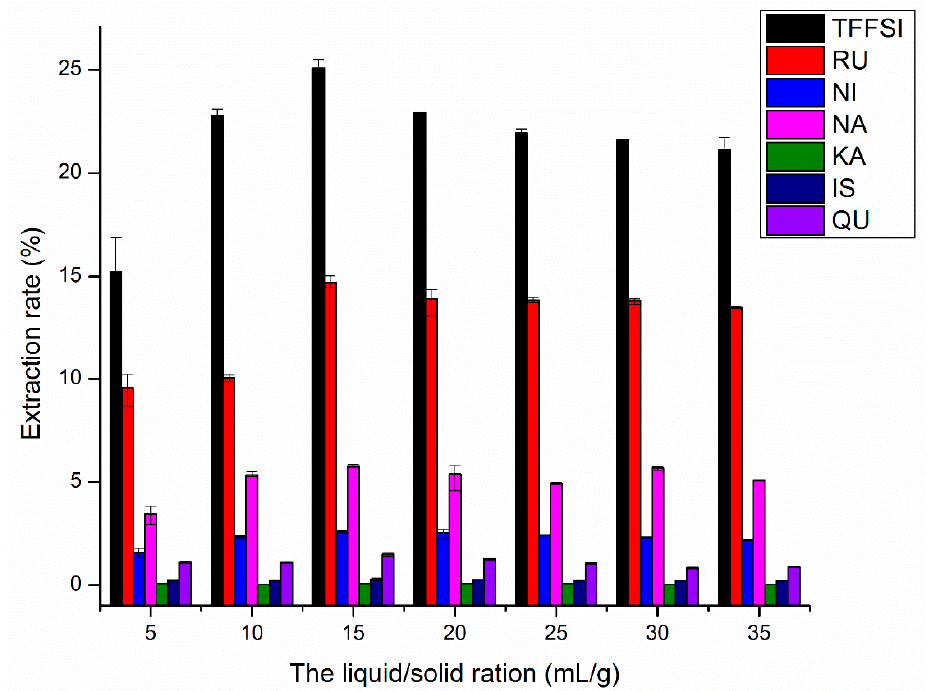
Figure 4. E ff ects of liquid–solid ratio on the extraction rates of RU, NI, NA, KA, IS, QU, and the TFFSI.